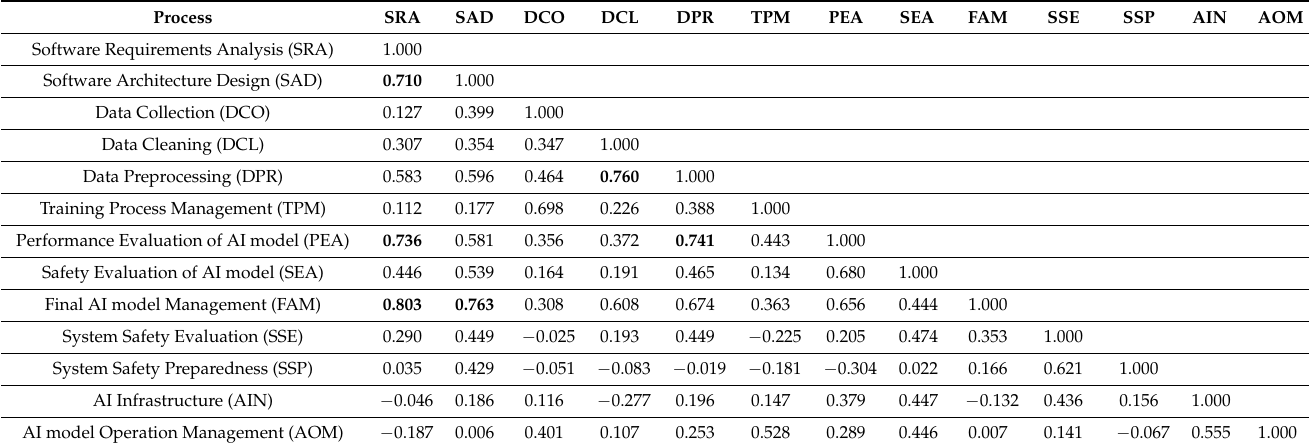
Table 10. Pearson coefficients among processes of AI-MM based on 13 AI projects (bold font is used for coefficients with an R value above 0.7).